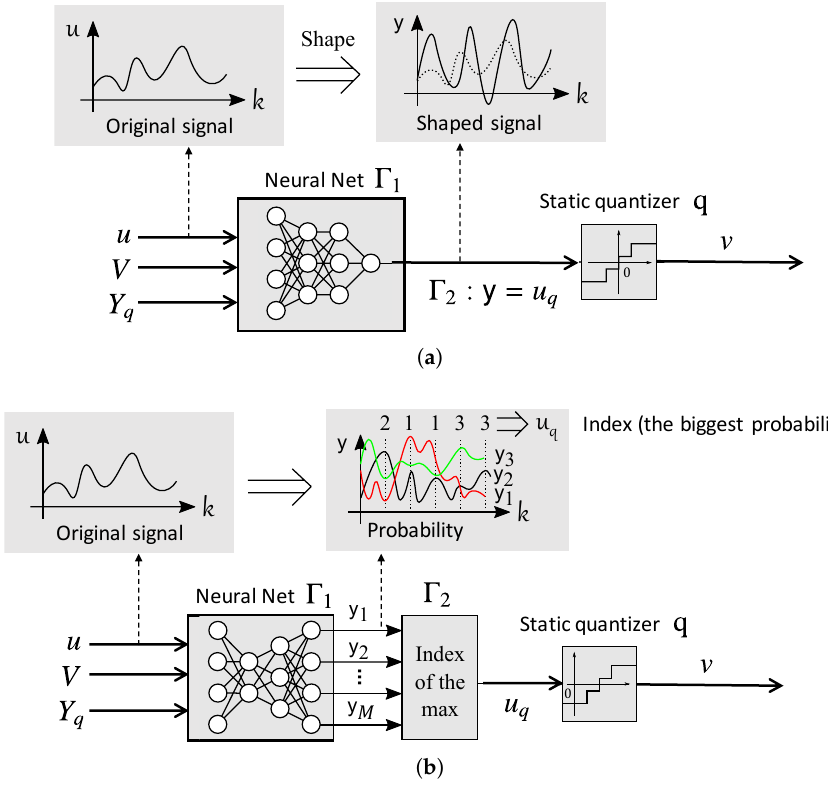
Figure 2. Difference between the neural network quantizer based on regression and the one based on classification. ( a ) Regression based approach. The neural net has one output and shapes the original signal; ( b ) Classification based approach. The number of the neural network output is same as that of quantization levels, and each output correponds to the probability that a original signal is classified into a specific quantization level.